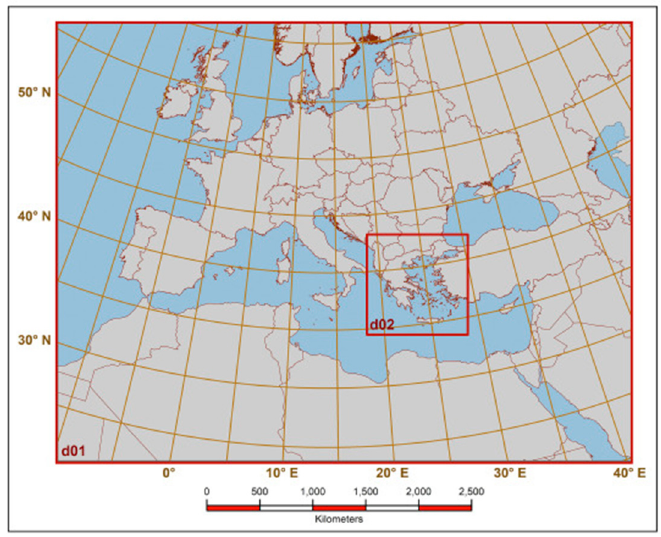
Figure 1. Modelling Domains: d01 refers to the outermost domain of 20 km and d02 to the nested domain of 5 km (region of Greece).